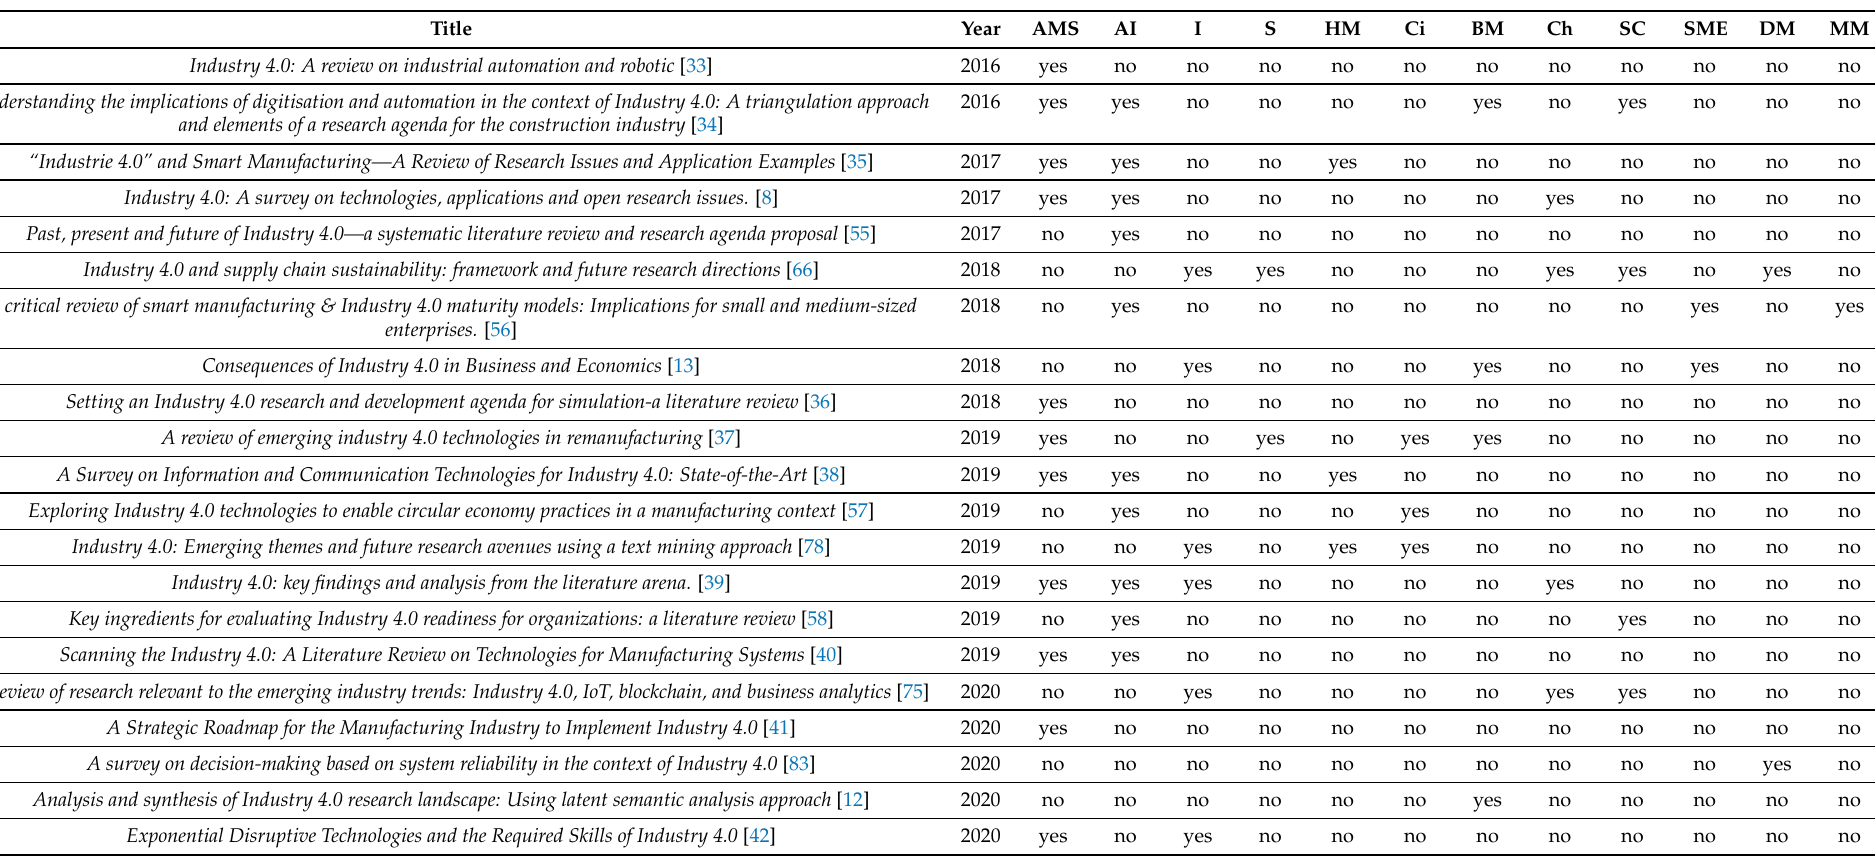
Table 4. Overview of the review papers about Industry 4.0, while their impact on the identified concepts and technologies is marked. The acronyms AMS, AI, I, and S reflect Advance Manufacturing Systems, Artificial Intelligence, Impact, and Sustainability. The terms Sustainability Human Machine collaboration, Circularity, Business Model, and Challenges are described as S, HM, Ci, BM, and Ch. Lastly, the columns SC, SME, DM, and MM refer to the Supply Chain, Small–Medium Enterprises, Decision-Making, and Maturity